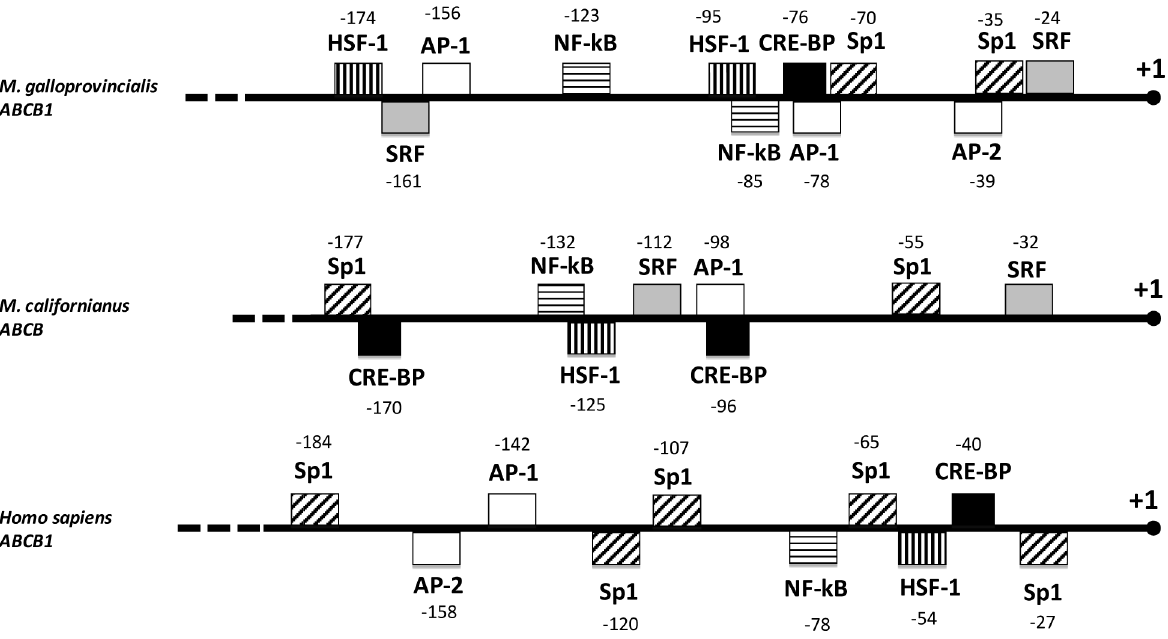
Figure 7. Untranslated 5 9 regulatory region of ABCB genes from the mussels M.galloprovincialisandM. californianus showing promoter elements. Numbering is relative to the transcription initiation site. Gene Bank Accession Numbers are FM999809 ( M. galloprovincialis ABCB1) and EF52141 ( M. californianus ABCB). Sequence of the human ABCB1 promoter in the same region is reported for comparison (GenBank Ac. Numb. NM000927). Furthermore, a more complete sequence analysis of the human ABCB1 promoter is reported by Scotto and Johnson [6] and Rohlff and Glazer [28].